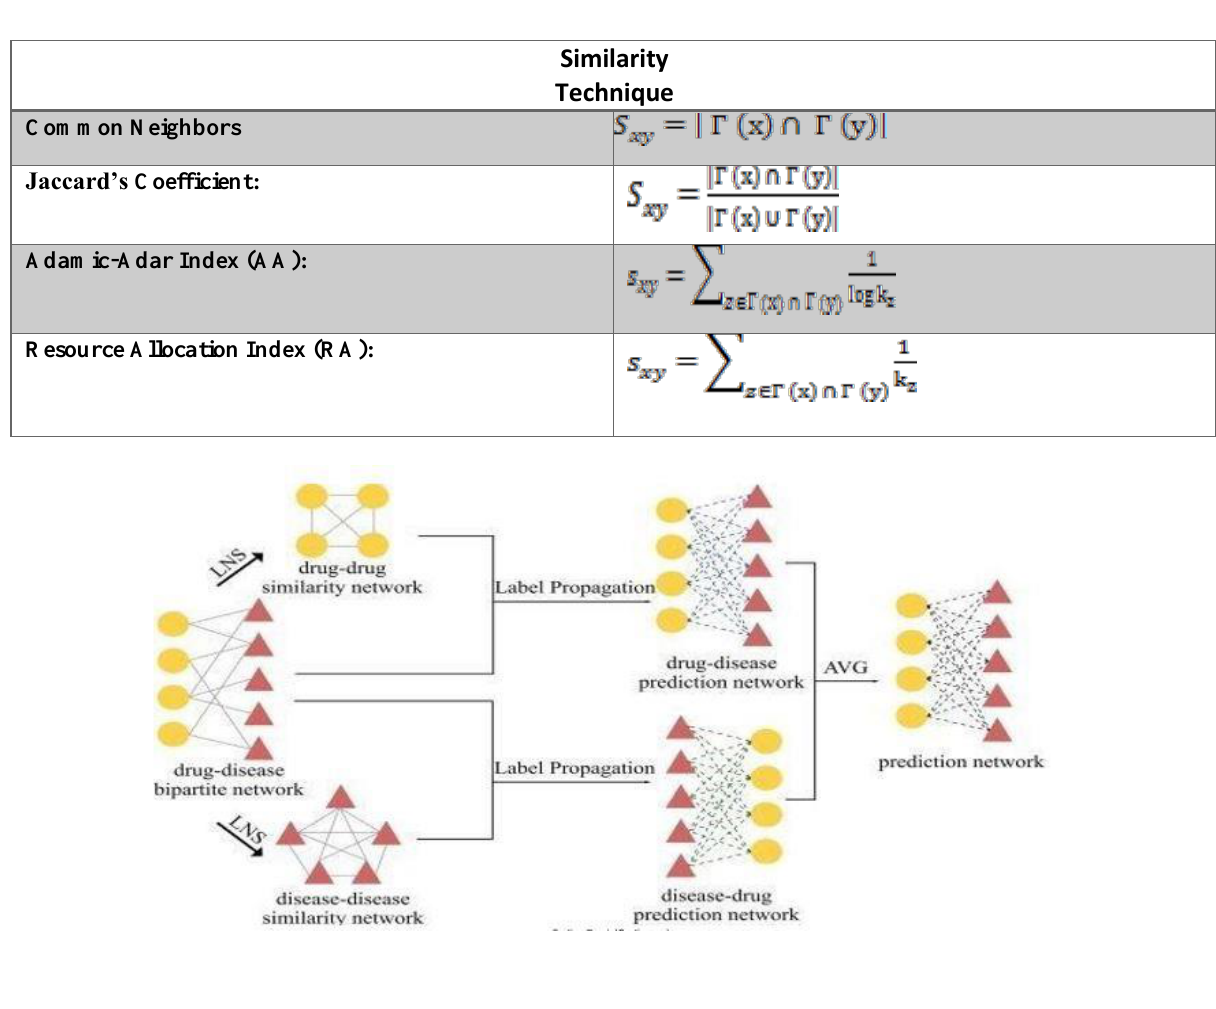
Table 1.Similairty Technique [15]